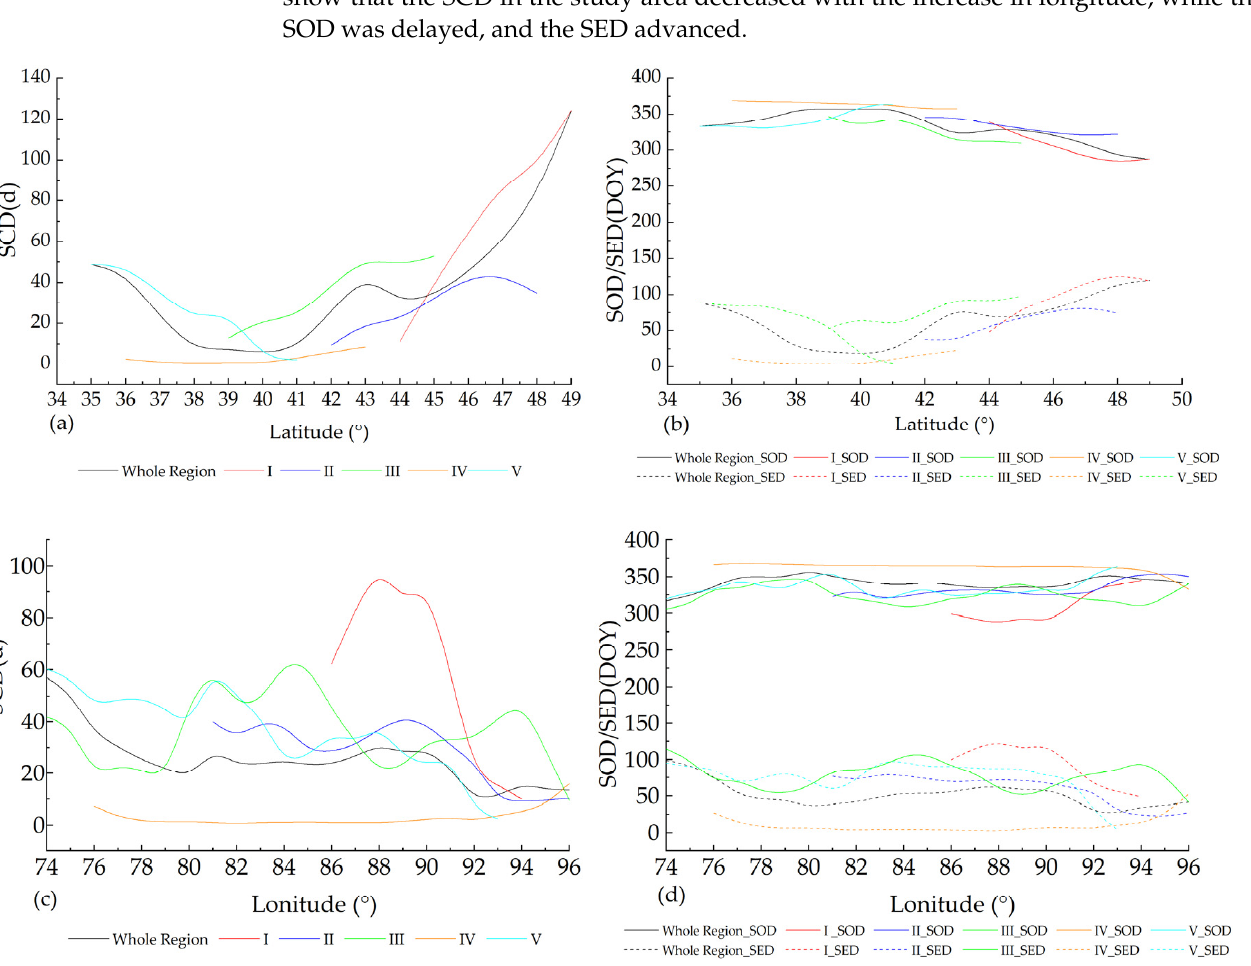
( b ) in latitude; SCD ( c ) and SOD/SED ( d ) in